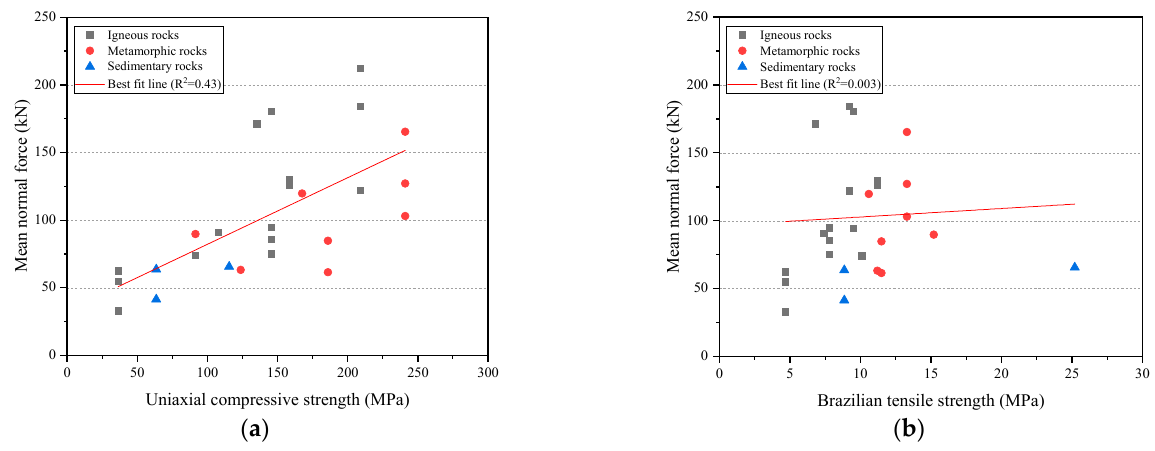
Figure 3. Relationship between mean normal force and rock strengths: ( a ) UCS; ( b ) BTS.